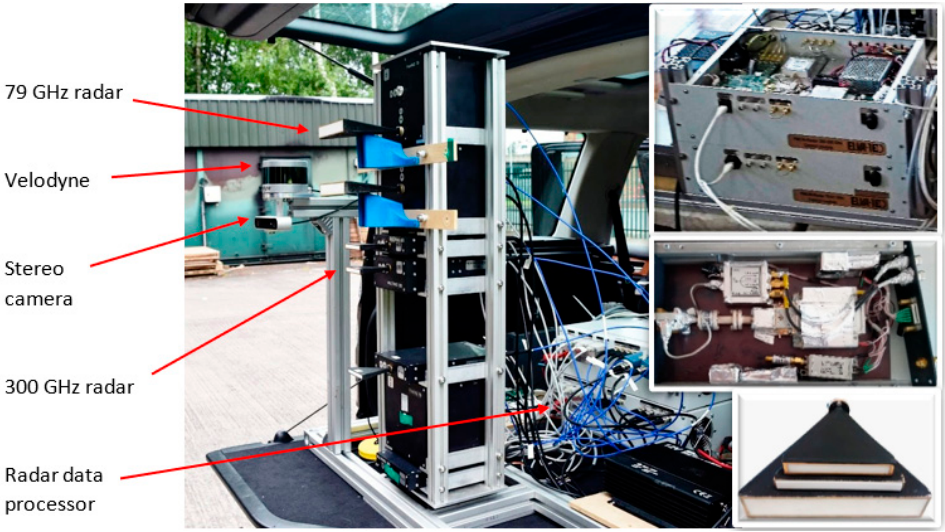
Figure 2. Sensor suite. The insets show (from top to bottom): radar data processor, radar board, antennas. The antenna parameters and parameters of the radars are shown in Table 1. The radars Table 1. Measurement system characteristics.